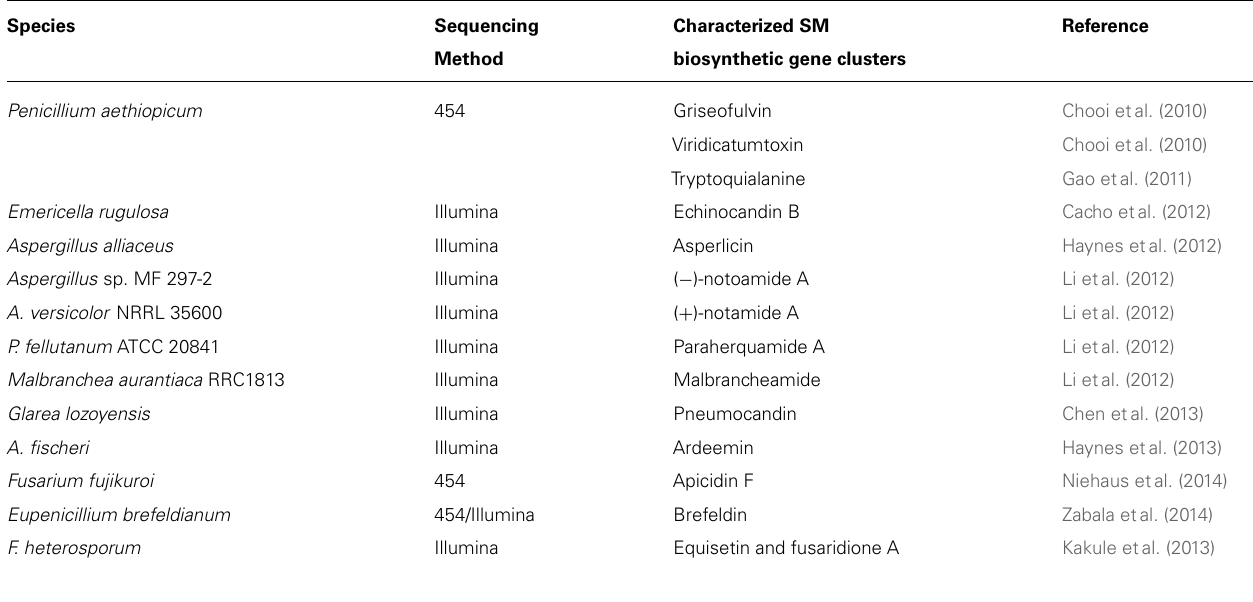
Table 1 | Examples of biosynthetic gene clusters assigned to their respective compounds using next-generation sequencing technology.